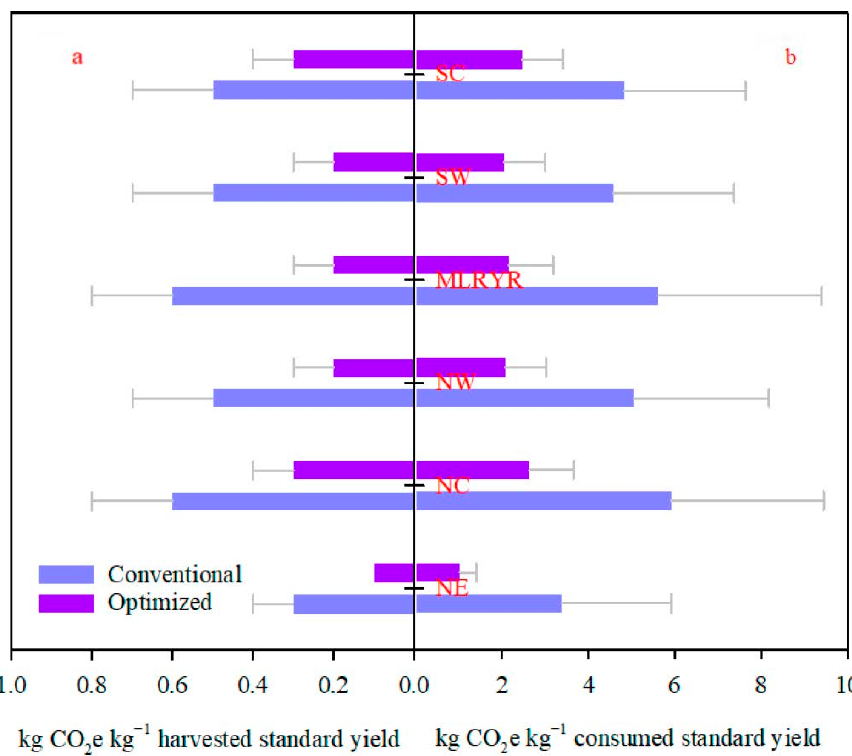
Figure 5. GHGI ( a ) and VCF ( b ) indicators of potatoes under conventional and optimized measures in the six cultivation regions. in the six cultivation